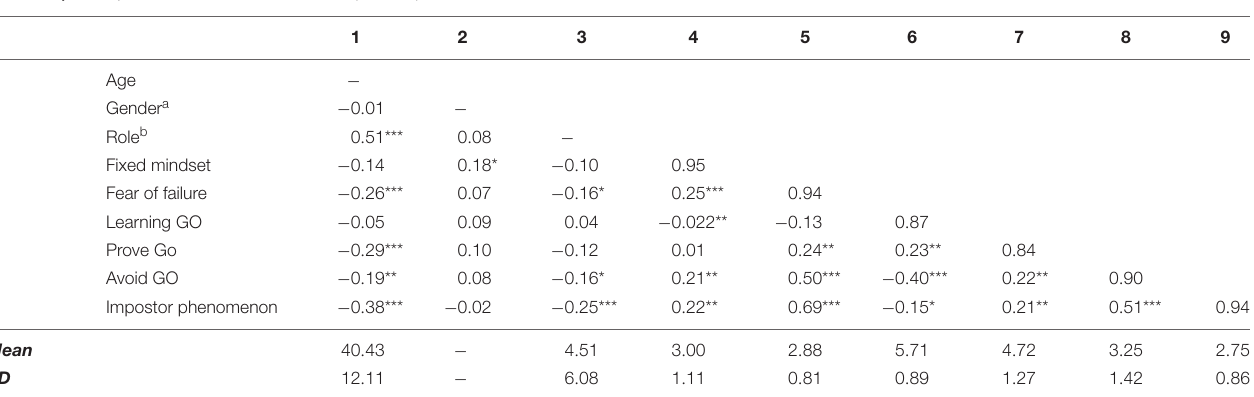
TABLE 2 | Descriptive statistics and correlations ( n = 201).